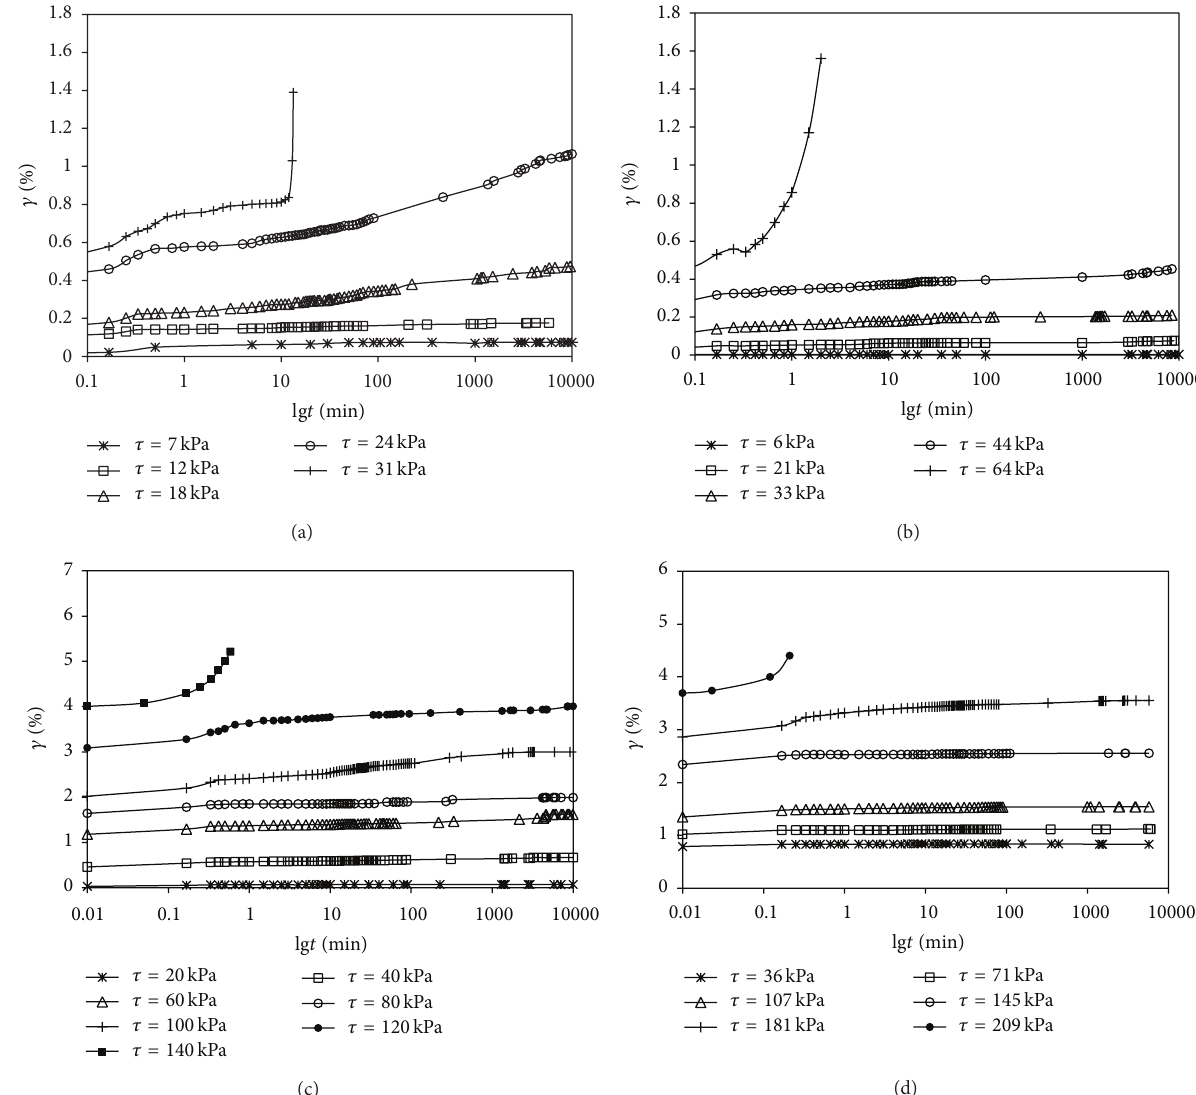
Figure 5: (a) Direct shear creep test for 𝑝 = 50 kPa. (b) Direct shear creep test for 𝑝 = 100 kPa. (c) Direct shear creep test for 𝑝 = 200 kPa. (d) Direct shear creep test for 𝑝 = 300